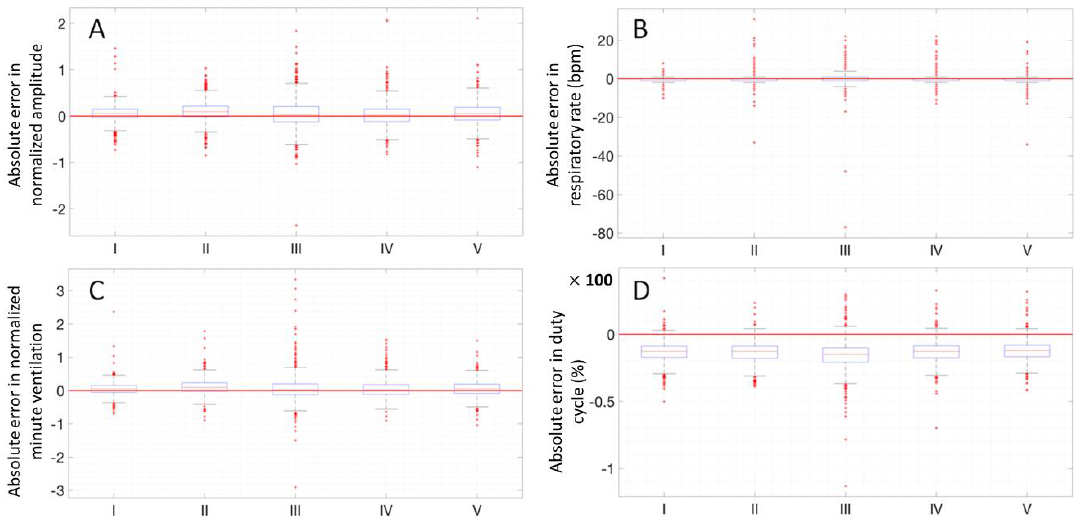
Figure 10. Absolute error box plots, all subjects, different positions at rest, all parameters: normalized amplitude ( A ), respiratory rate ( B ), normalized minute ventilation ( C ) and duty cycle ( D ). The positions shown are the following: standing (I), seated (II), supine (III), right side (IV), left side (V).